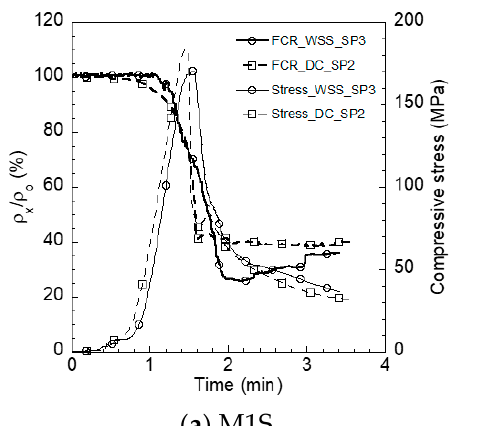
Figure 15. FCR at peak stress of S-UHPCs under compression.